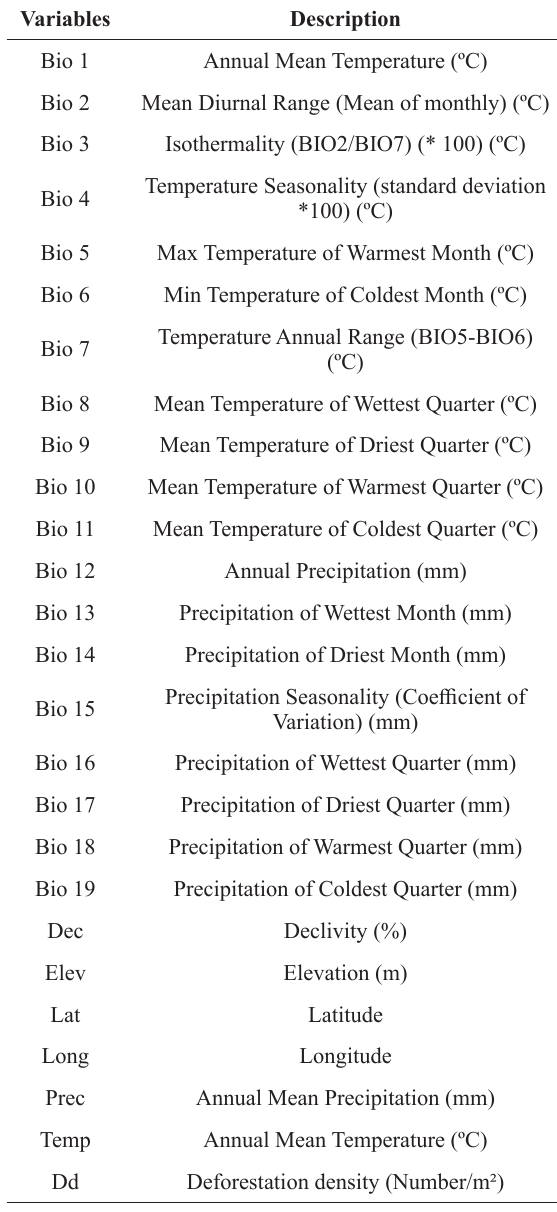
Variables used for modelling the wood volume in Cerrado Sensu Stricto in the state of Minas Gerais, southeast